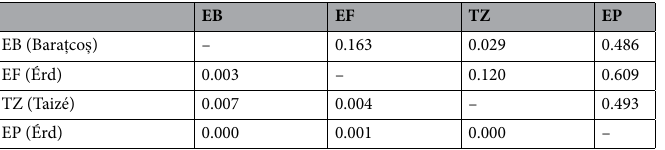
Table 2. Pairwise genetic differentiation values (G ST ) below the diagonal, and their probability value based on 999 permutations above the diagonal as calculated in GenAlEx.